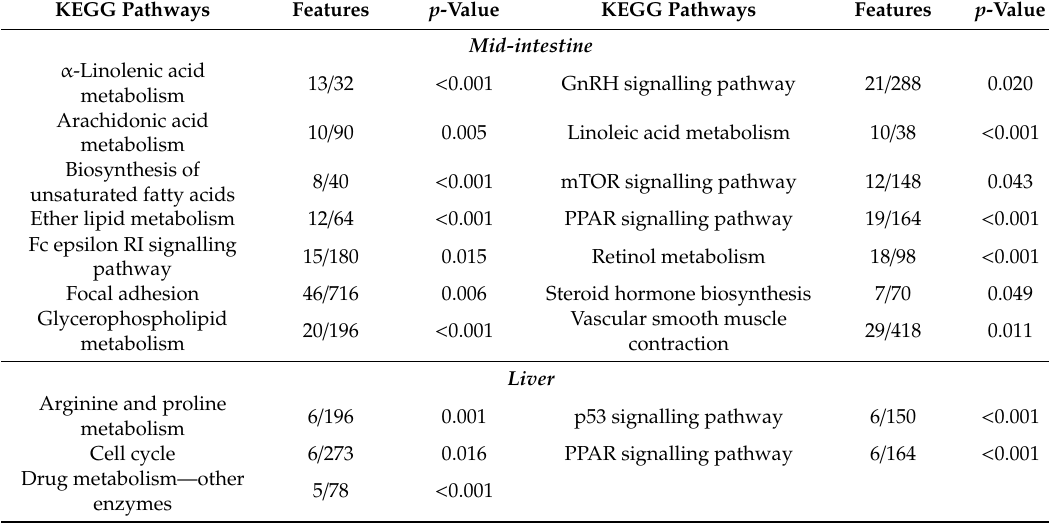
Table 6. KEGG pathways of genes that were di ff erentially expressed in mid-intestine and liver of salmon fed with the WG-containing diets in comparison to the FM controls ( n = 6; two fish per three replicate tanks). Features represent the number of DEGs that were enriched of the genes included in the microarray platform. The significance ( p -value) of the enrichment was assessed by the Yates’ corrected chi-square